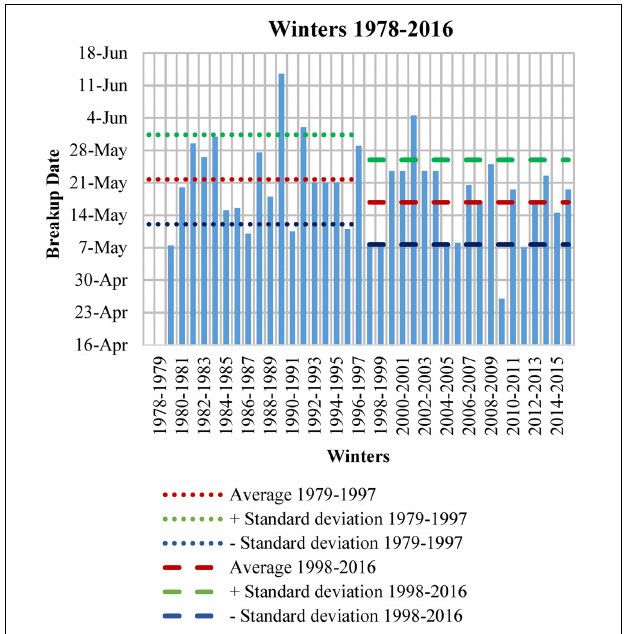
FIGURE 12 | Comparison of breakup dates in James Bay for 1979–1997 and 1998–2016 periods adapted from Taha et al. (2017).